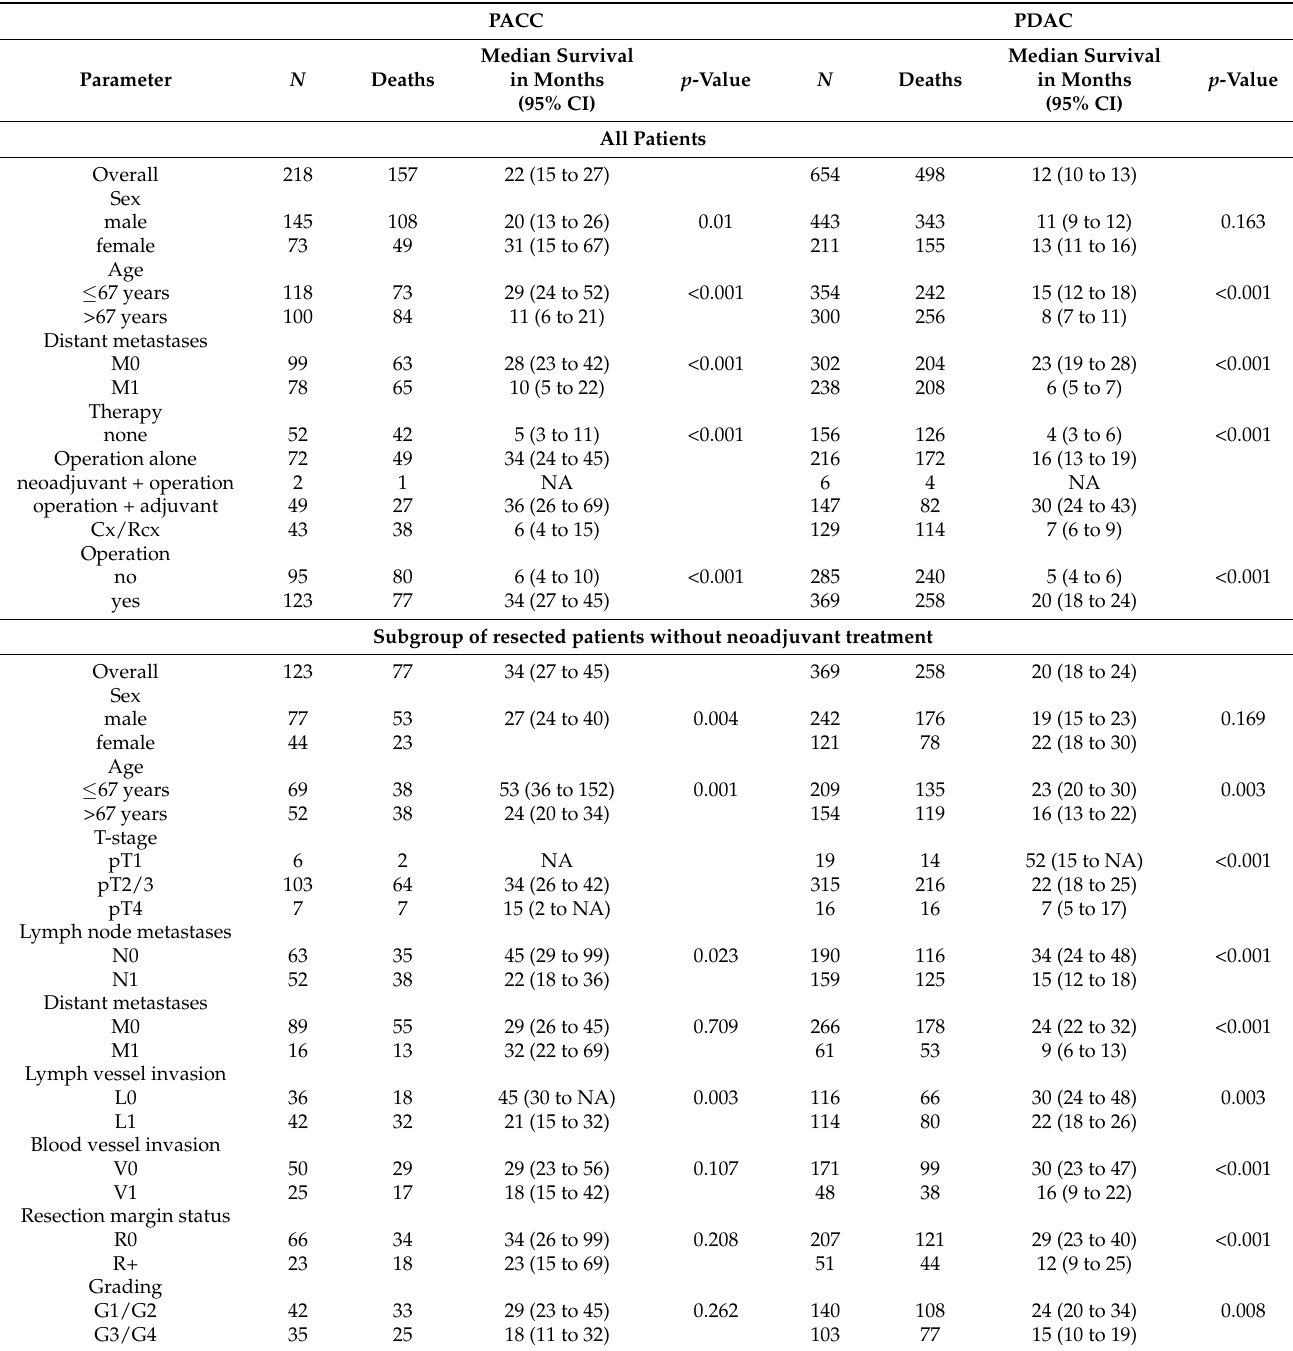
Table 2. Univariable survival analysis for PACC and the propensity score matched PDAC